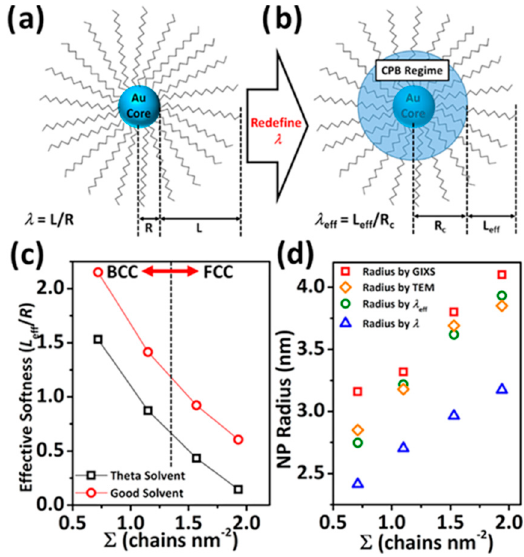
Figure 3. Illustrations of ( a ) the conventional concept of softness ( λ ) of nanoparticles (NPs) and ( b ) the concept of effective softness ( λ eff ). ( c ) Effective softness variation as a function of grafting density ( Σ ). ( d ) Comparison between the effective NP radius predicted by λ (blue triangle), λ eff (green circle), and experimental results obtained from transmission electron microscopy (TEM, orange diamond) and grazing incidence x-ray scattering (GIXS, red square) (Reproduced with permission from [26]. Copyright American Chemical Society, 2019 ) .